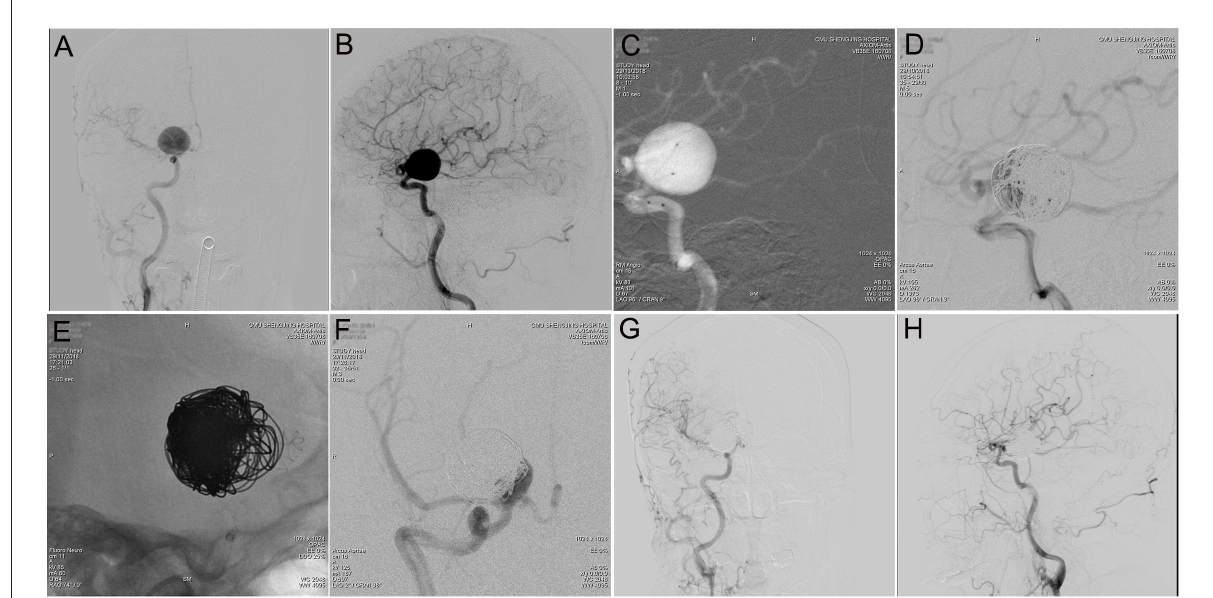
FIGURE2 Tubridge TM treatment of a giant wide-necked aneurysm in the clinoid segment of the internal carotid artery. (A) DSA results shows a giant wide-necked aneurysm in the clinoid segment of the right internal carotid artery; (B) working angle measurement indicates an aneurysm size of approximately 21.4mm × 20.5mm and an aneurysm neck of 13mm; (C) application of the double-microcatheter technique with spring ring embolization of the aneurysm to support the second-stage Tubridge TM release; (D) immediate postoperative imaging to complete most of the aneurysm embolization; (E) after 1 month, the second stage of Tubridge TM release is 3.0 × 25, and the stent is massaged by the microcatheter to make the stent fit the wall completely; (F) immediate DSA imaging shows a small amount of residual aneurysm neck; and (G,H) 2 years after surgery, DSA re-examination shows complete healing of the